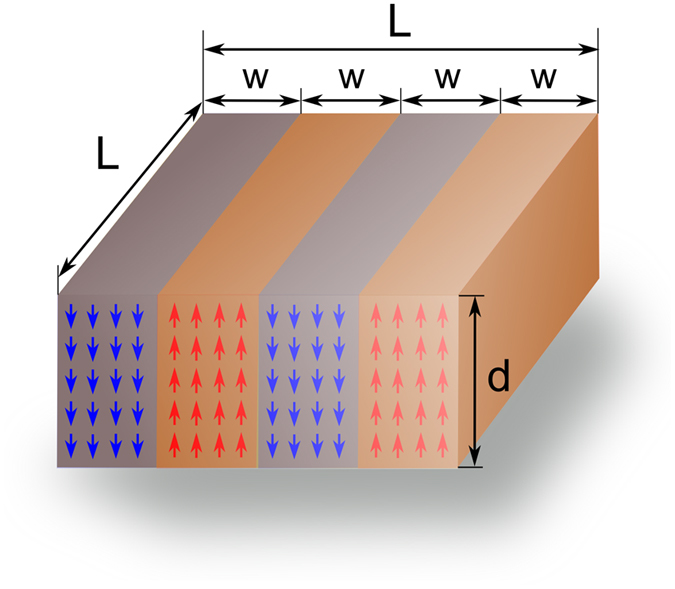
A schematic representation of 180o stripe domains in a given PbTiO3 nanodot, where L, w, and d are described in the text.